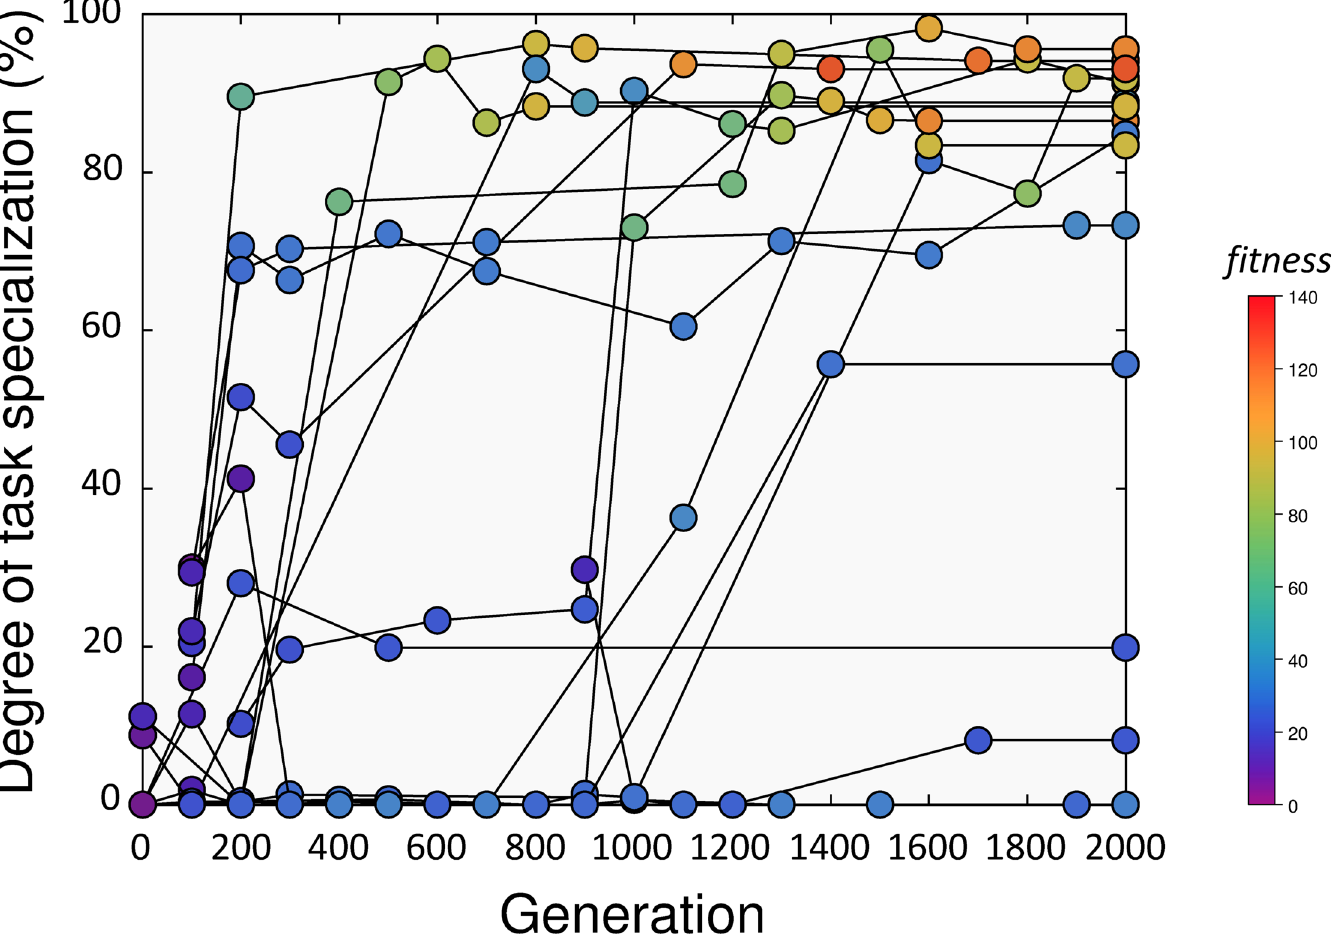
Fig 4. Group performance and degree of task specialization displayed by 4 robot teams over subsequent generations for each of the 22 evolutionary runs. The degree of task specialization (Y axis) is measured as the proportion of items retrieved by more than one robot over the total number of items retrieved. The group fitness (color-coded) is the total number of items retrieved to the nest over a period of 5,000 simulated seconds averaged over 2 simulation runs. The degree of task specialization and the group fitness of the best evolved controller in each generation is shown over subsequent generations for each of the 22 evolutionary runs. High task partitioning was evolutionarily stable, since any transition to high task partitioning never reverted back to generalist foraging in later generations. Some controllers, however, did not evolve task partitioning as a result of being trapped in local